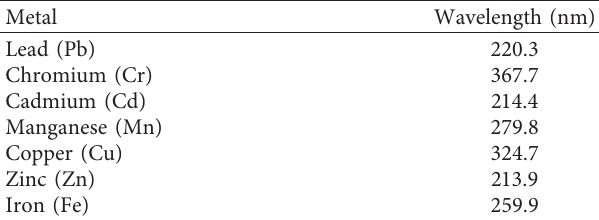
Table 3: List of wavelengths selected for the respective